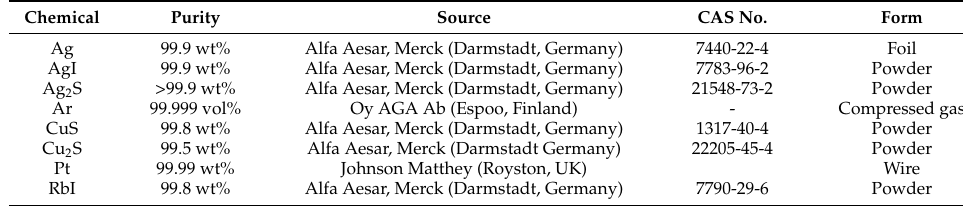
Table 1. Purity and provenance of the chemicals consumed in the experiments.